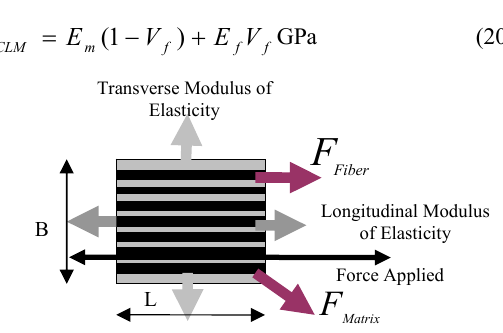
Figure 5: Composite structure having aligned fibers with orientation at 0 0 along the direction of the force applied.